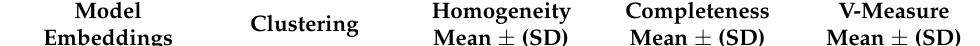
Table 4. Performance metrics (in %) attained by using the models with different clustering